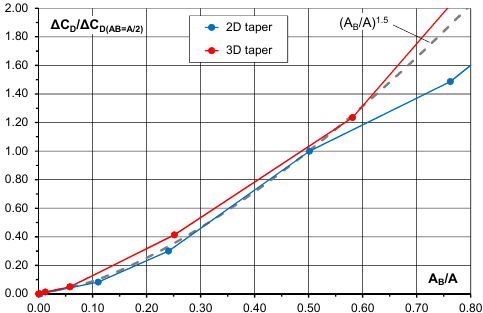
Figure 9. Drag increase from truncating streamlined tail.